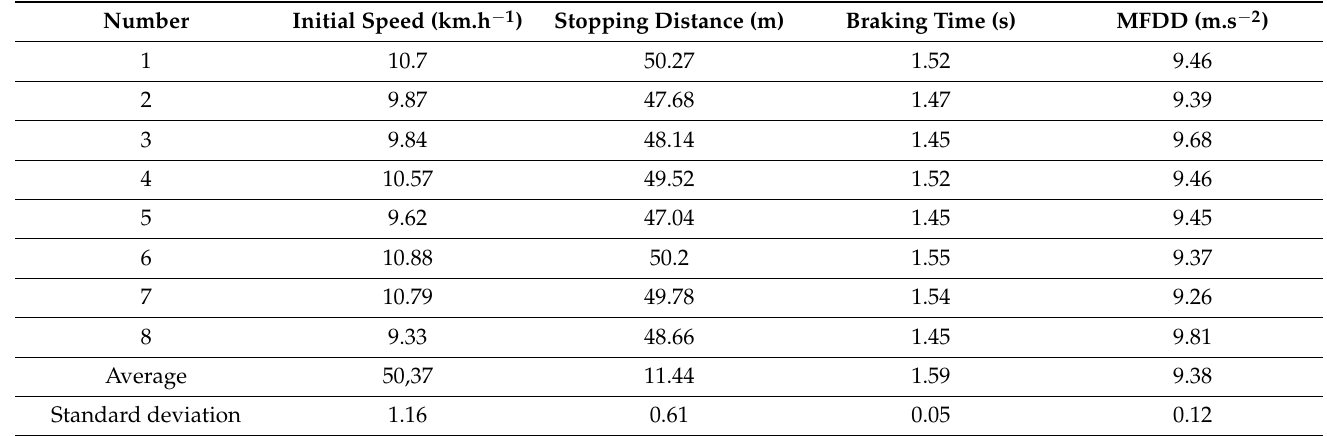
Table 5. Braking characteristics measured with low-priced brake components.